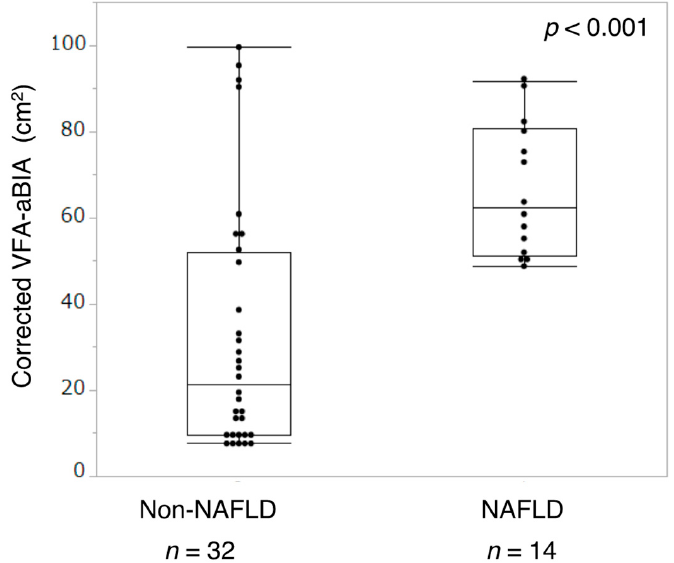
Figure 6. Relationship between corrected VFA-aBIA and NAFLD. VFA-aBIA—visceral fat area measured by abdominal bioelectrical impedance analysis using EW-FA90 (Panasonic Corporation, Osaka, Japan); NAFLD—non-alcoholic fatty liver disease.